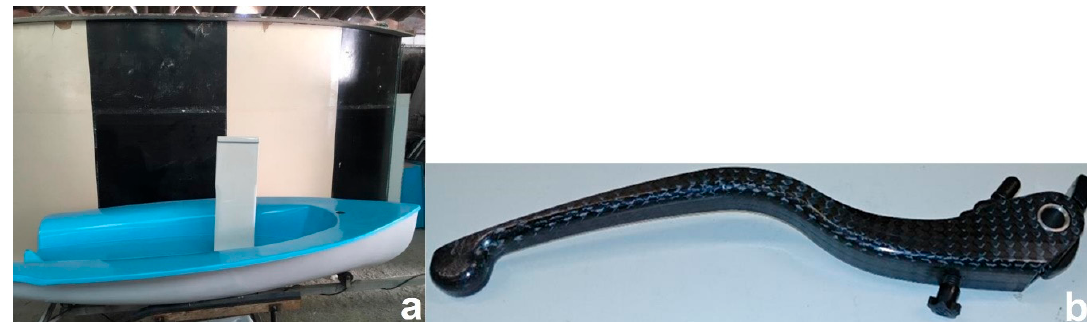
Figure 9. MODCOMP project advanced material prototypes: ( a ) sailing boat; ( b ) lever.